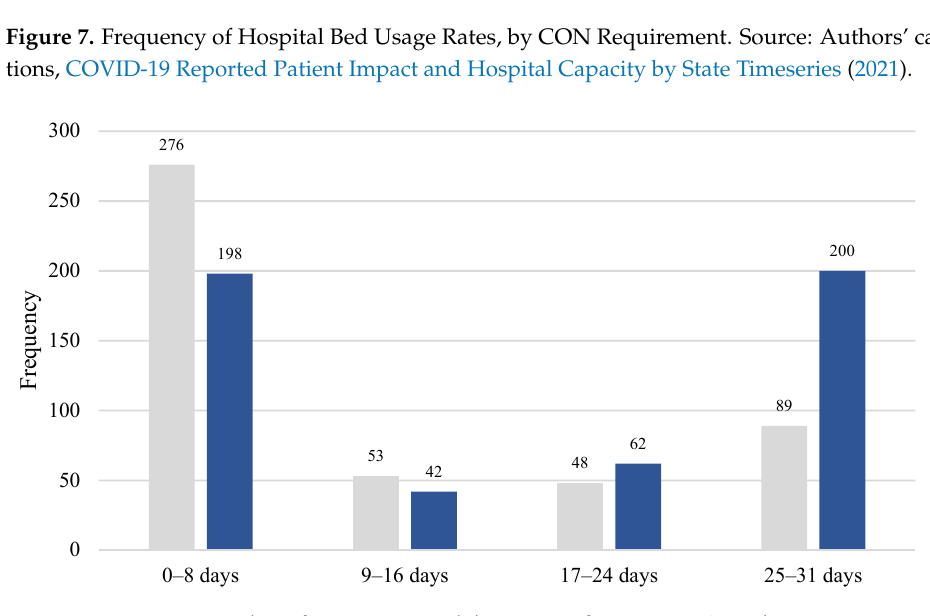
Figure 8. Frequency of Days per Month in Excess of 70 Percent Capacity, by CON Requirement.